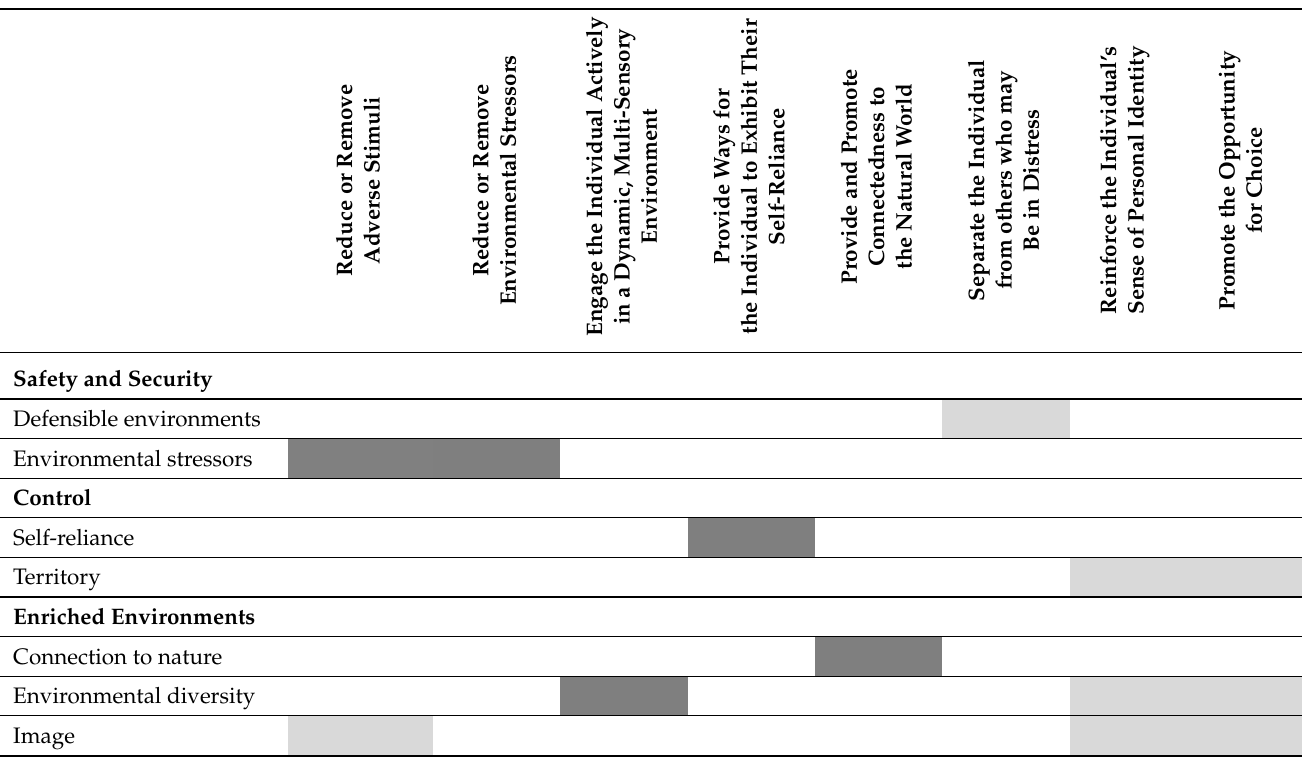
Table 4. Mapping of Domains and Themes to Trauma-informed Design (TID)